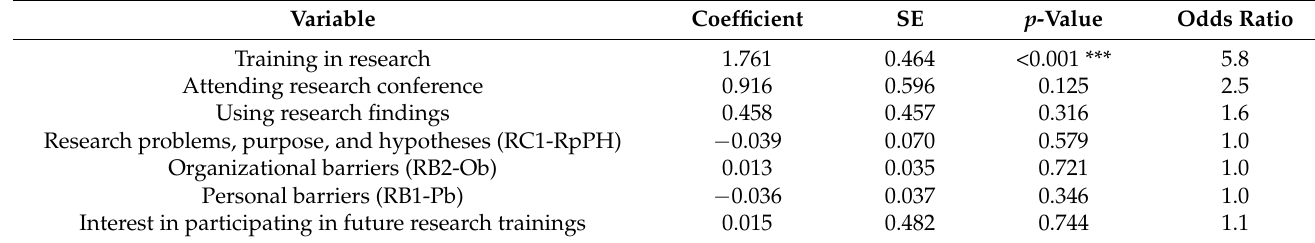
Table 6. Coefficient of variables to predict research